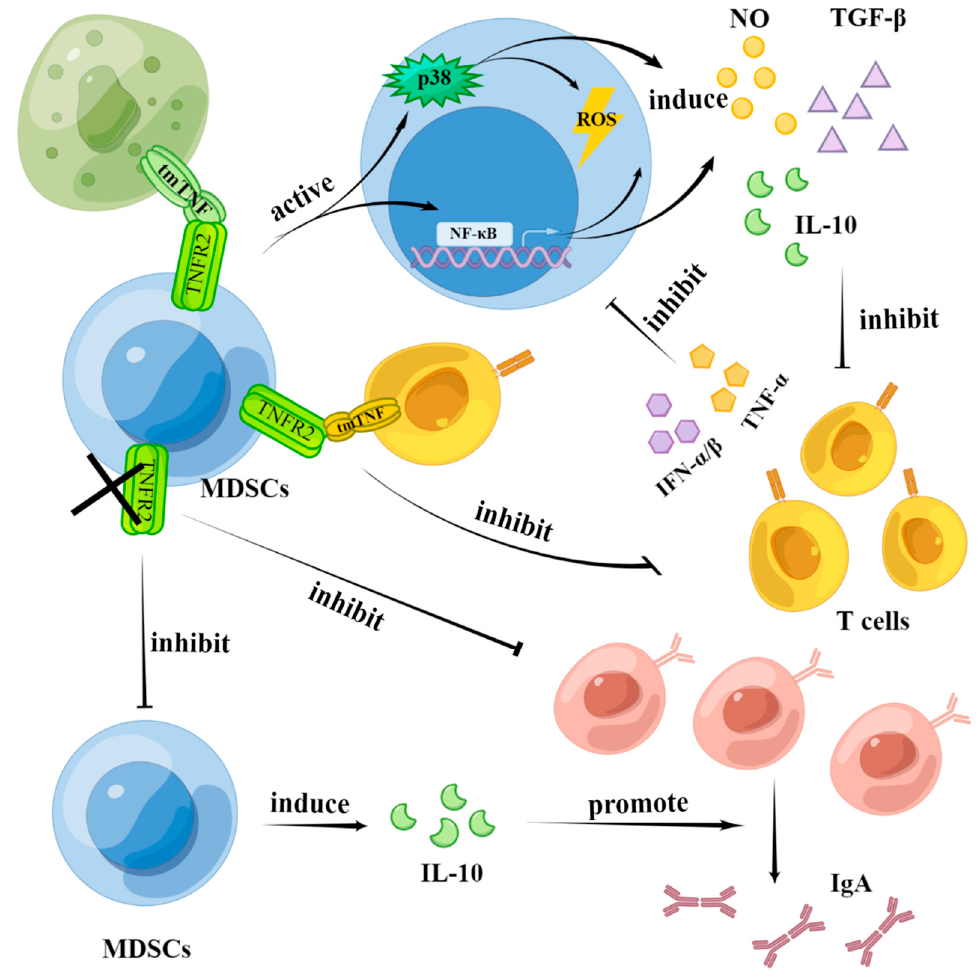
Figure 3. The effects of TNF signaling in the function of MDSCs. TNF signaling pathways enhance the inhibitory effect of MDSCs on T cells. tmTNF activates the immunosuppressive function of MDSCs by activating NF- κ B and p38 signaling pathways mediated by TNFR2. By secreting immunosuppressive mediators including NO, ROS, IL-10 and TGF- β , MDSCs inhibit the proliferation and function of T cells. Activated-memory T cells then inhibit the immunosuppressive function of MDSCs by secreting TNF- α and IFN- α / β . Additionally, tmTNF in MDSCs interacts with TNFR2 in CD4+ T cells. This is necessary for the inhibitory effect of MDSCs on CD4+ T cells. In terms of B cells, a specific blockade of TNFR2 in MDSCs can inhibit cell proliferation. Finally, MDSCs can secrete IL-10 in a TNFR2-dependent manner, promoting the activation of B cells and the production of IgA. The figure was created using Figdraw (https://www.figdraw.com/ accessed on 19 August